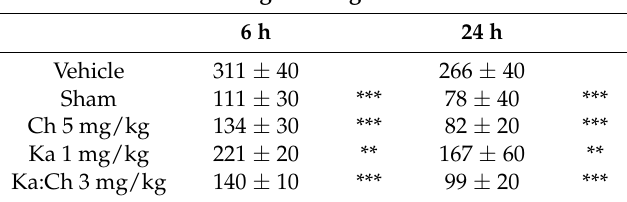
Table 1. The effects of kaempferol (Ka) and chrysin (Ch) individual and combination treatments on liver tissue myeloperoxidase (MPO) activity.